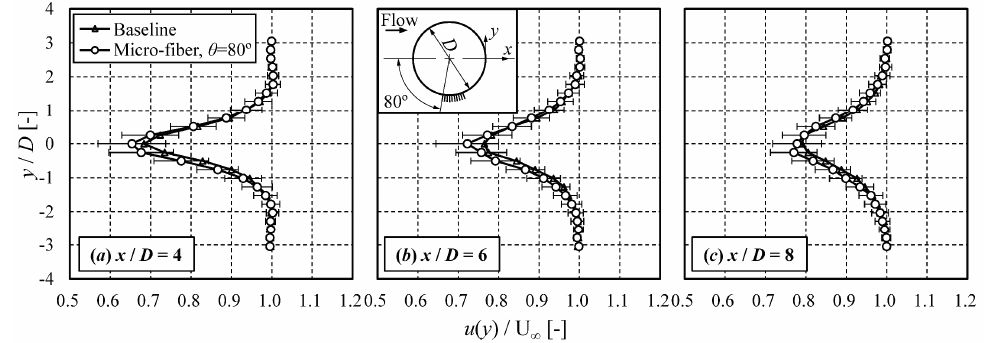
Figure 6. Comparison of mean velocity profiles in wake for baseline and microfiber at θ = 80°: ( a ) x / D = 4; ( b ) x / D = 6; ( c ) x / D = 8.